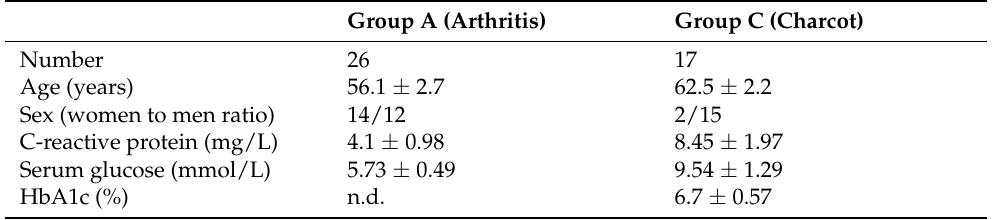
Table 1. Characteristics of included patients.